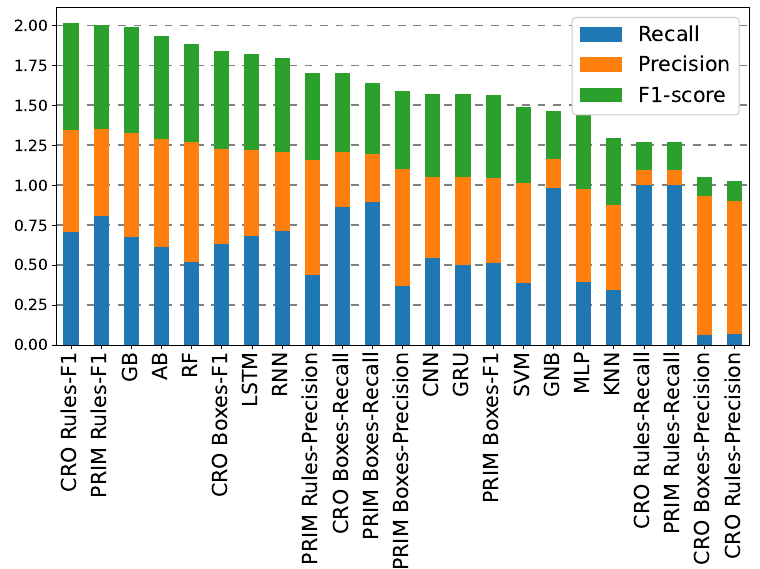
Figure 14. Comparison of the test performance of the different methodologies assessed for a time prediction horizon of +3 h.